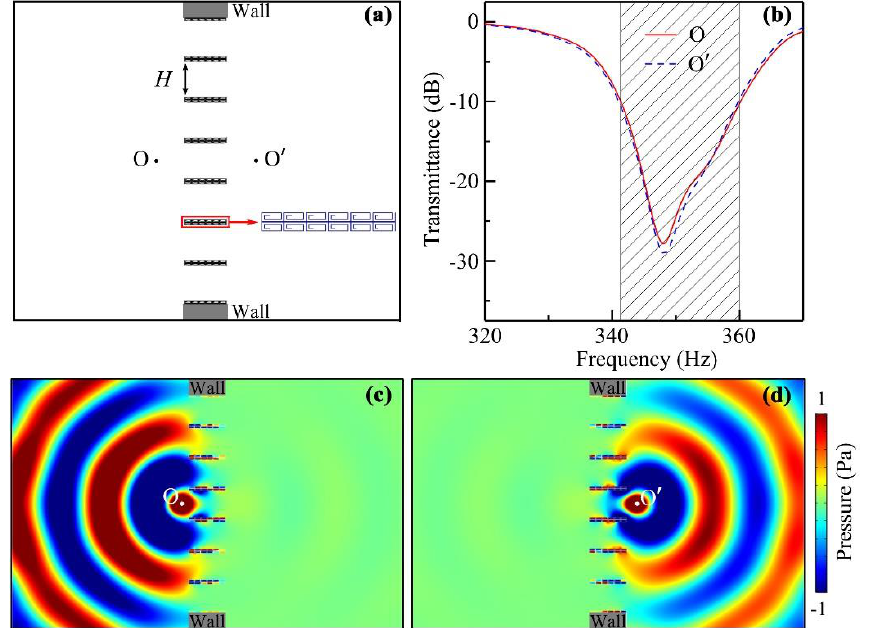
Figure 7. ( a ) Schematic of an open-window structure with low-frequency low-reflection BSI, in which a cylindrical sound source was separately placed at the point O or O′. ( b ) We simulated transmittance spectra through the open window by separately placing a cylindrical sound source at the point O and O′. We also simulated pressure distributions through the open window by separately placing a cylindrical sound source at the points ( c ) O and ( d ) O′ at 348 Hz.